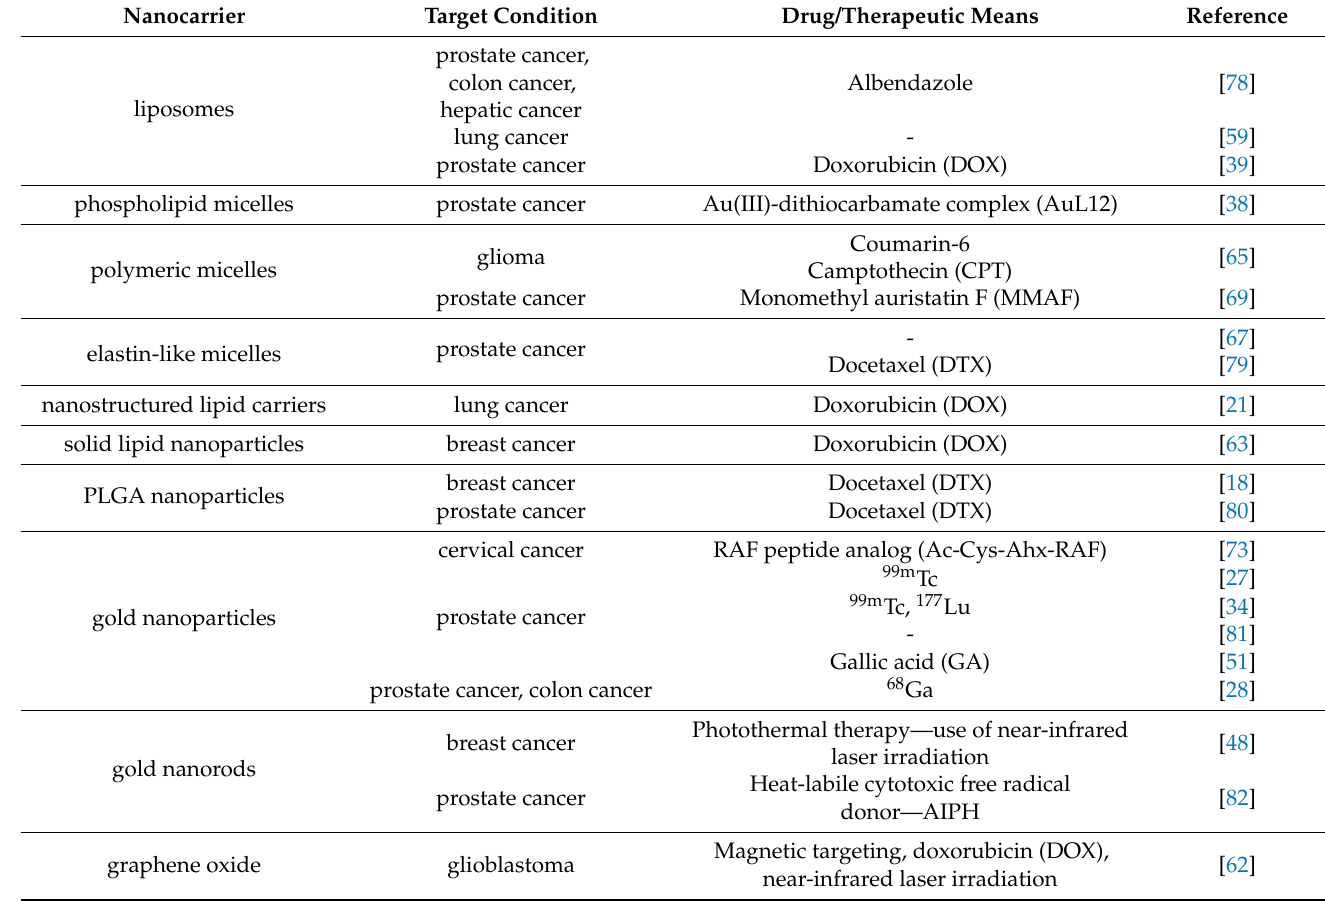
Table 1. Contemporary GRPR-targeted nanosystems for cancer